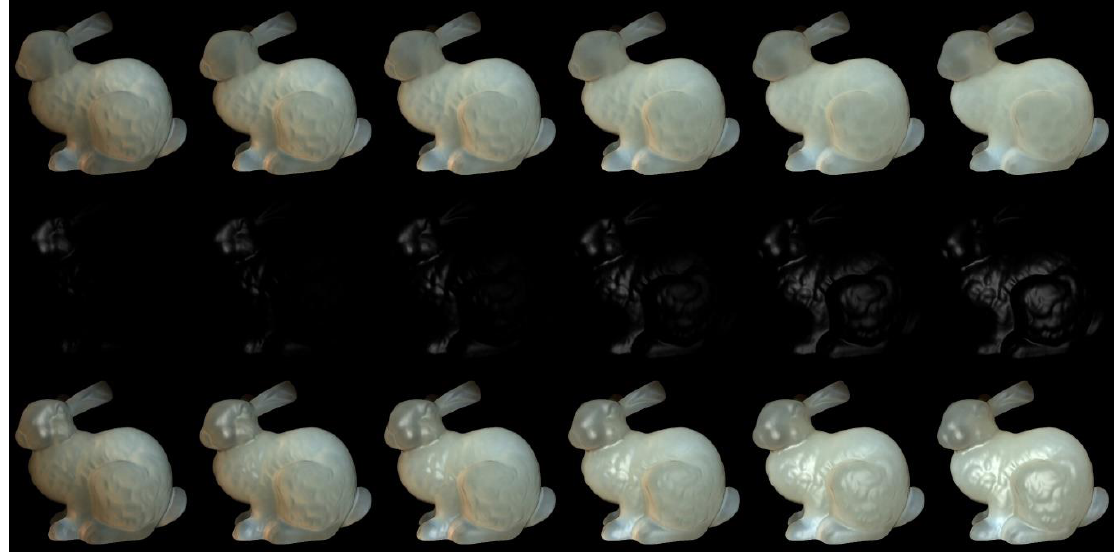
Figure 2. Visual appearance of rendering of chocolate milk (regular) under slant illuminant angles from nearly overhead to nearly horizontal. From left to right, the elevation angles are 10 ◦ , 25 ◦ , 40 ◦ , 55 ◦ , 70 ◦ , and 85 ◦ . First row: rendering results by directional light without adding highlight effects. Second row: generated highlight effects under the same illuminant conditions of the first row. Third row: rendering results by adding highlight effects of the other two rows at the same elevation angles.